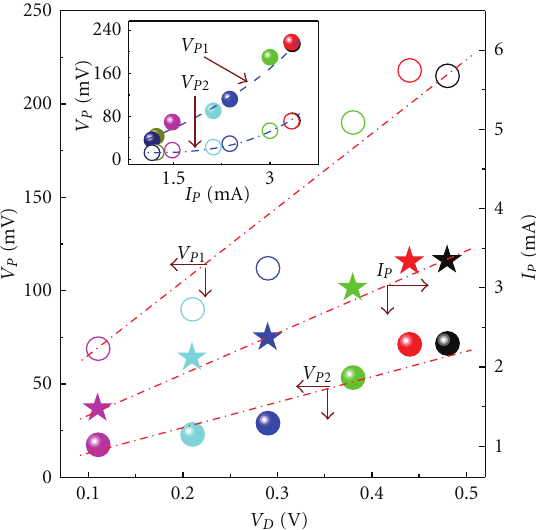
Figure 4: Di ff usion potential V D dependences of V p , V p 2 , and I p . The inset shows the relations between V p 1 , V p 2 , and I p